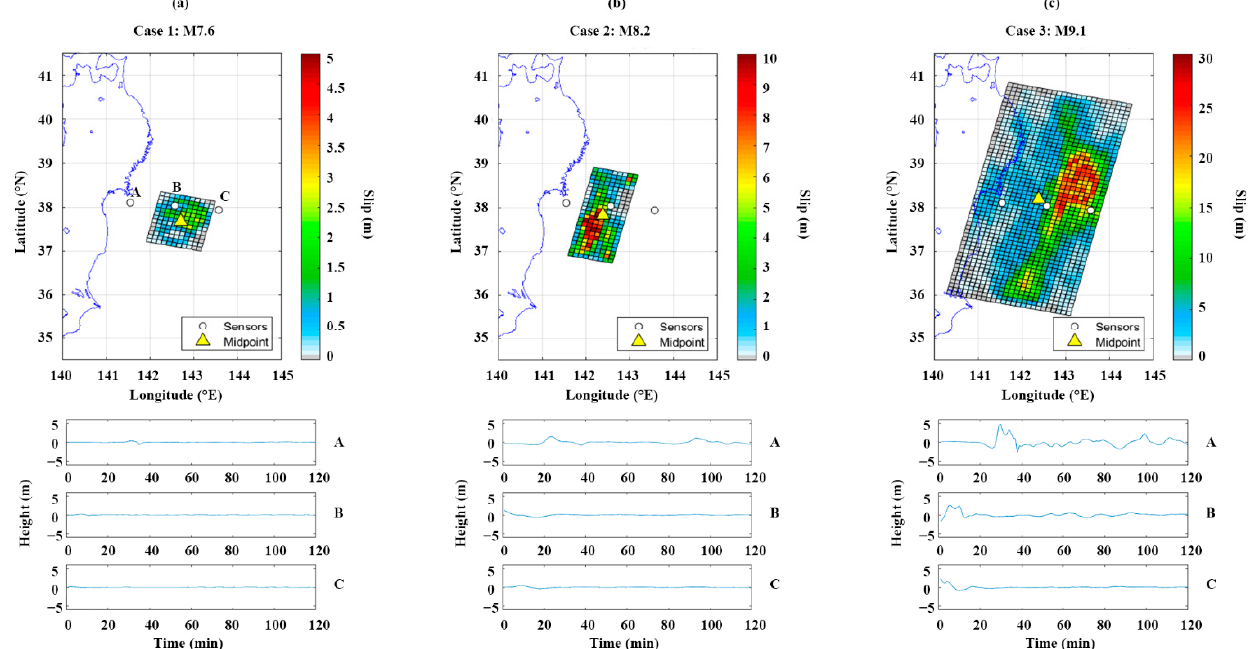
Figure 3. Earthquake rupture and tsunami wave plots for three individual cases of ( a ) M7.6, ( b ) M8.2, and ( c ) M9.1. The yellow triangle represents the midpoint of the earthquake rupture. There are three off-shore sensors, which are A, B and C representing near, middle, and far locations from the coastline. A greater earthquake magnitude tends to generate a larger earthquake rupture in size and higher tsunami waves.